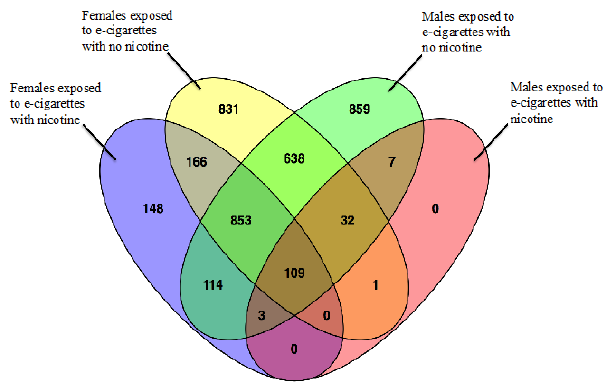
Figure 3. Quantity of overlapping and unique genes between treatment groups and sex. The Venn diagram displays overlapping and unique genes found to be significantly changed ( p < 0.01) via RNA-Seq analysis between treatment groups and sex, as indicated. Diagram created using Venny [19] .